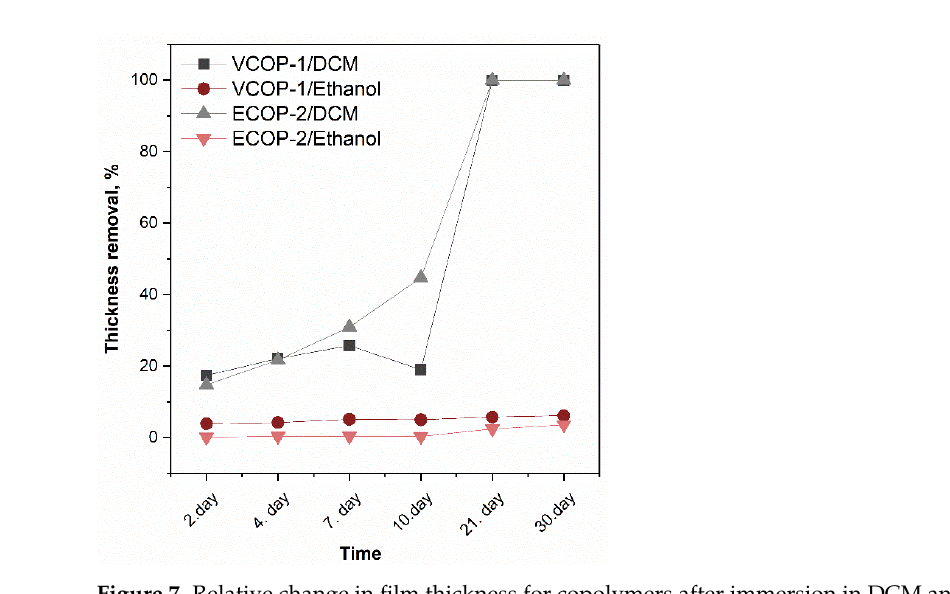
Figure 7. Relative change in film thickness for copolymers after immersion in DCM and ethanol.